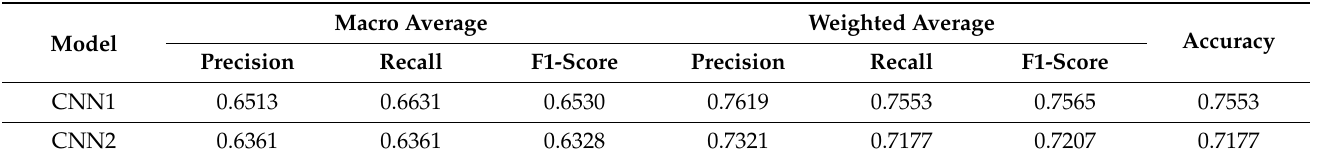
Table 5. Performance of CNN1 and CNN2 in HAR, with the SI strategy and 9 subjects on